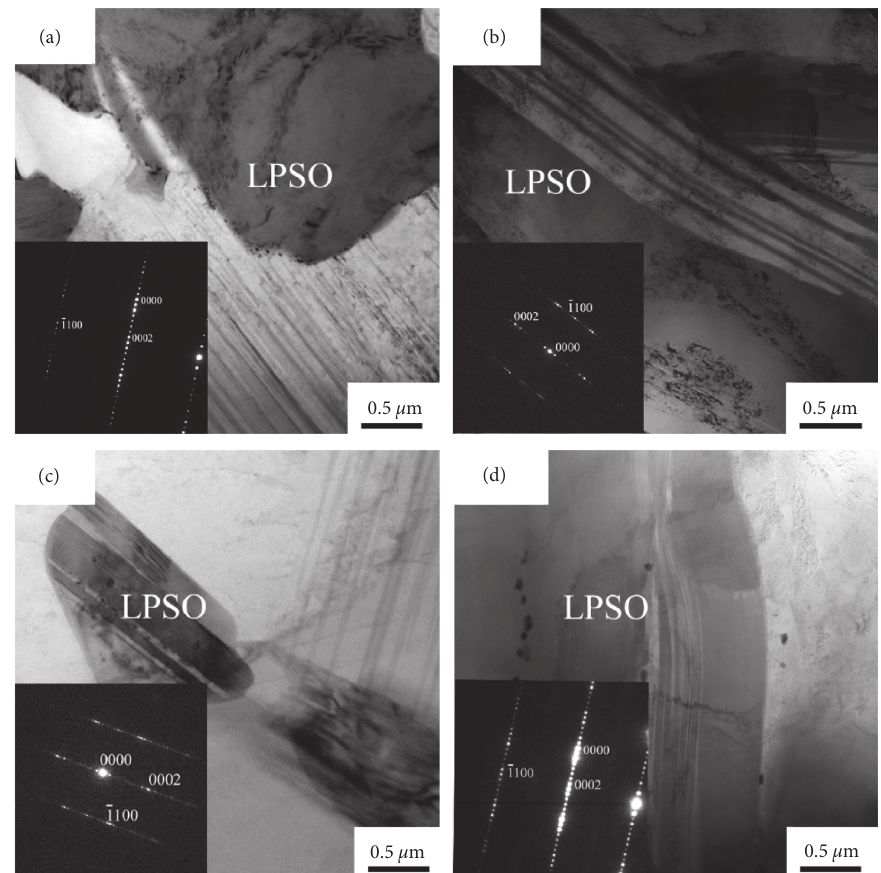
Figure 5: TEM bright field images and the corresponding SAED patterns of (a) MYZ, (b) MYZC, (c) MYZN, and (d) MYZCN alloys.